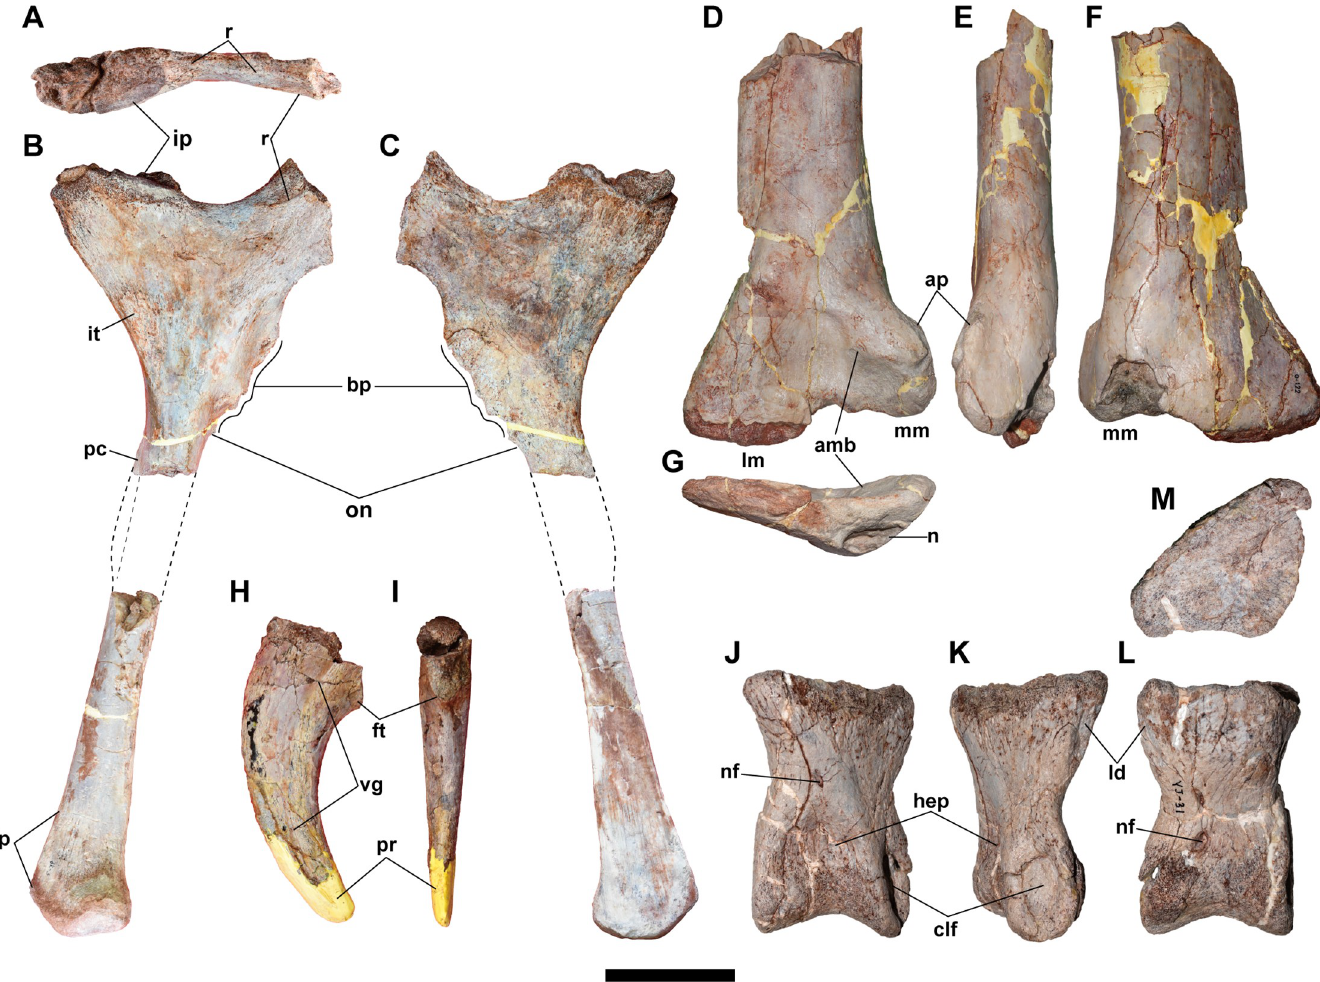
Fig 11. Appendicular skeleton of the new taxon. Right ischium (NRRU-F01020019 and F01020020) in proximal (A), lateral (B), and medial (C) views, right tibia (NRRU-F01020021) in anterior (D), medial (E), and posterior (F) views, manual ungual (NRRU-F01020018) in lateral (H) and palmar (I) views, and left pedal phalanx IV-1 (NRRU-F01020022) in dorsal (J), lateral (K), plantar (L), and proximal (M) views. Abbreviations: amb, anteromedial buttress; ap, apex of the medial malleolus; bp, broken end of the obturator process; clf, collateral ligament fossa; fp, flange-like projection; ft, flexor tubercle; hep, hyperextensor pit; ip, iliac peduncle; it, ischial tuberosity; ld, longitudinal depression; lm, lateral malleolus; mm, medial malleolus; n, notch; nf, nutrient foramen; on, obturator notch; pc, posterior crest; pr, plaster reconstruction; r, ridge; vg, vascular groove. Scale bar equals 100 mm for A–G and 50 mm for H–M.